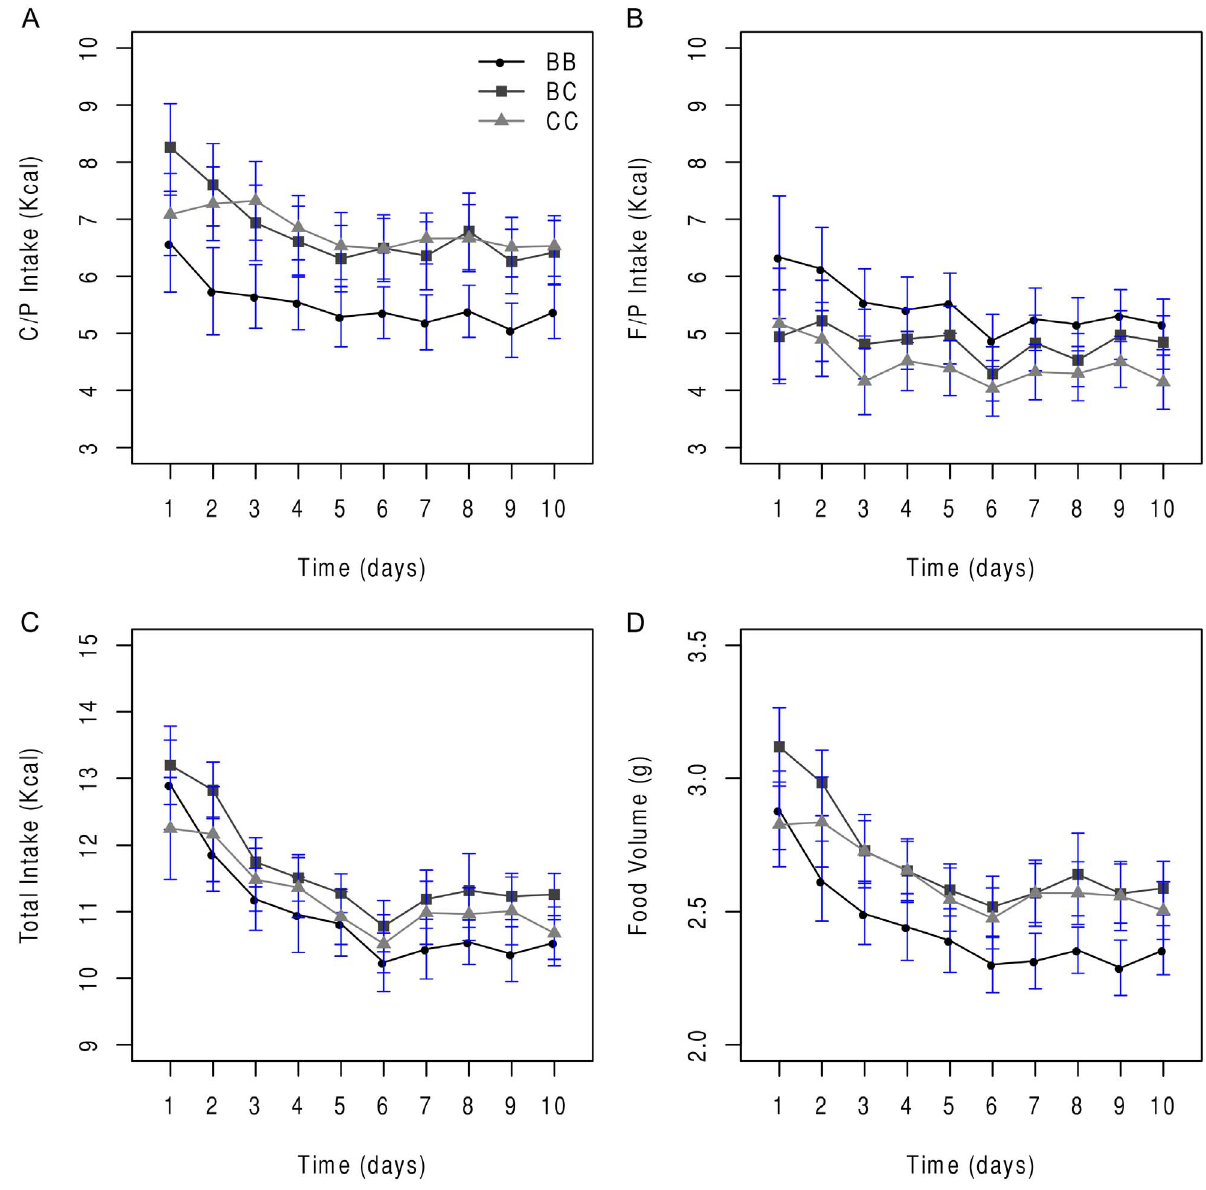
Figure 2. Non-recombinant B6.CAST-17.1 F 2 mice exhibit increased intake of carbohydrate kcal, total kcal and total food volume. Legend: Daily consumption of (A) carbohydrate/protein kcal (C/P) versus (B) fat/protein kcal (F/P), total kcal (C) and total food volume (D) in non- recombinant B6.CAST-17.1 F 2 mice. Values are mean 6 SE. Relative to b6/b6 F 2 , both cast/cast ( P , 0.005, Tukey-Kramer) and b6/cast ( P , 0.001) F 2 mice consumed more C/P kcal (A), with the exception of day 1 when b6/cast . b6/b6 F 2 mice= cast/cast F 2 [genotype by day: F (18, 1187)=2.16, P , 0.003]. By contrast, the b6/b6 F 2 ate more F/P kcal when compared to cast/cast F 2 ( P , 0.008) but not b6/cast F 2 ( P =0.10) (B), during the 10 d study. With respect to total kcal, all genotypes displayed a pronounced hyperphagic response to the diets at the beginning of the study, which subsided gradually over time [day: F (9, 938)=21.10, P , 0.0001], independent of genotype [genotype 6 day: F (18, 938)=0.94, P =0.53]. Relative to b6/b6 F 2 , both cast/cast ( P , 0.005) and b6/cast ( P , 0.0001) F 2 mice consumed more total g over 10